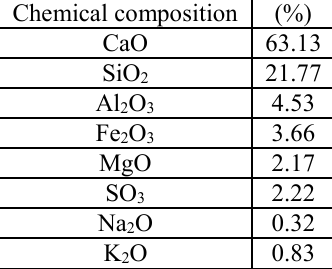
Chemical composition of cement